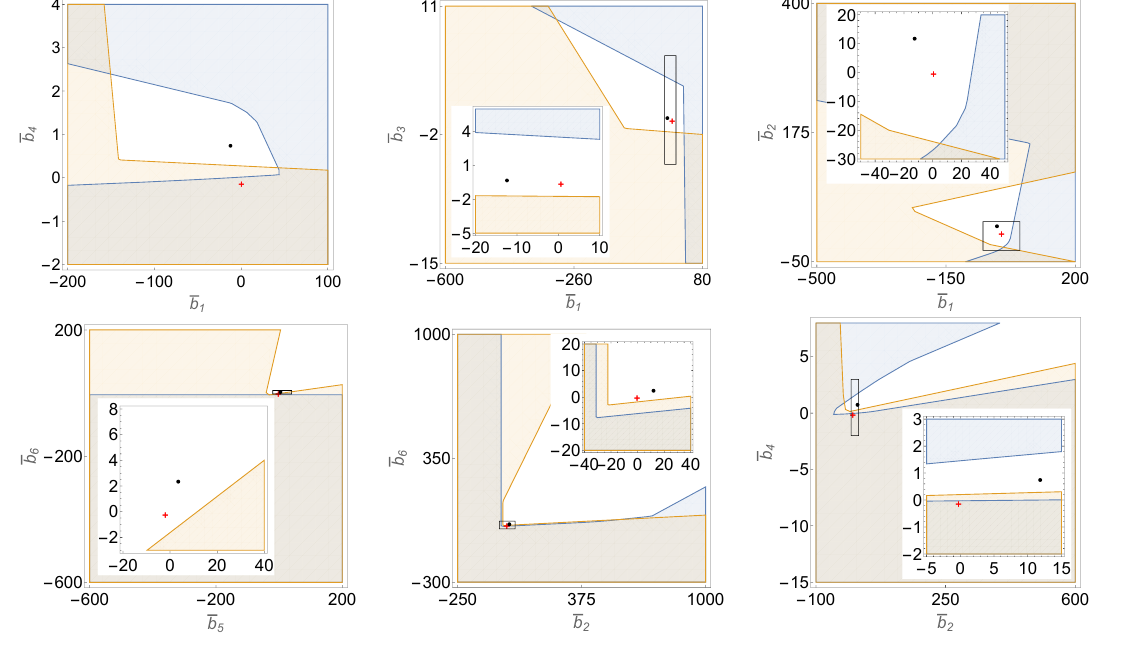
Figure 7 . Continuation of (cid:12)gure